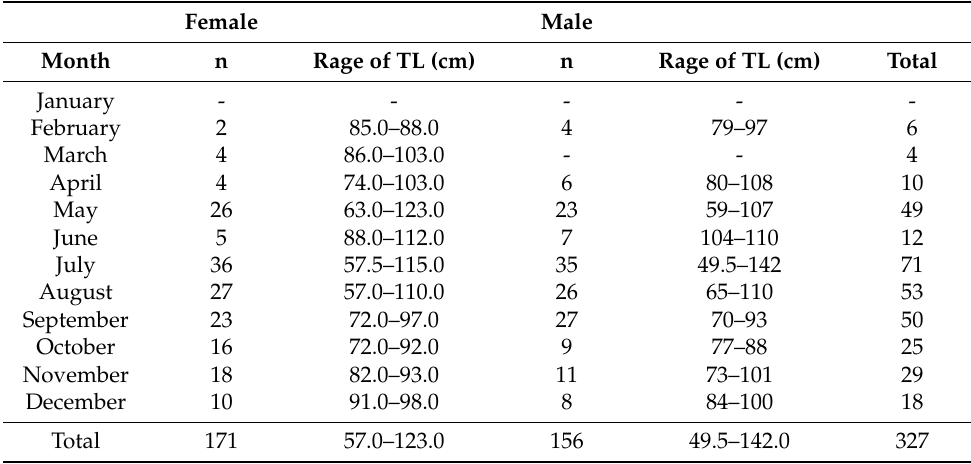
Table 1. Specimens of the spot-tail shark collected in this